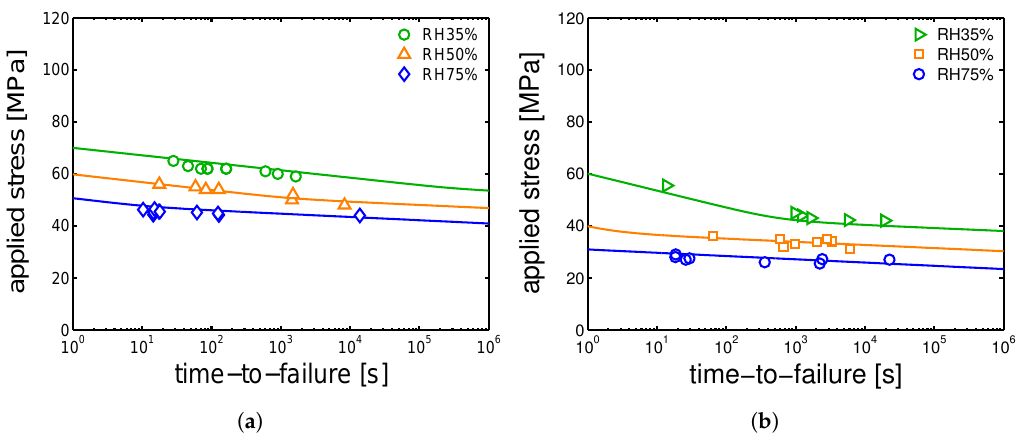
Figure 19. Creep tests for samples conditioned at RH 35%, RH 50%, RH 75% and 23 °C; applied loads as functions of time-to-failure for ( a ) α -I and ( b ) γ -I samples. Lines are the results of Equation (5).